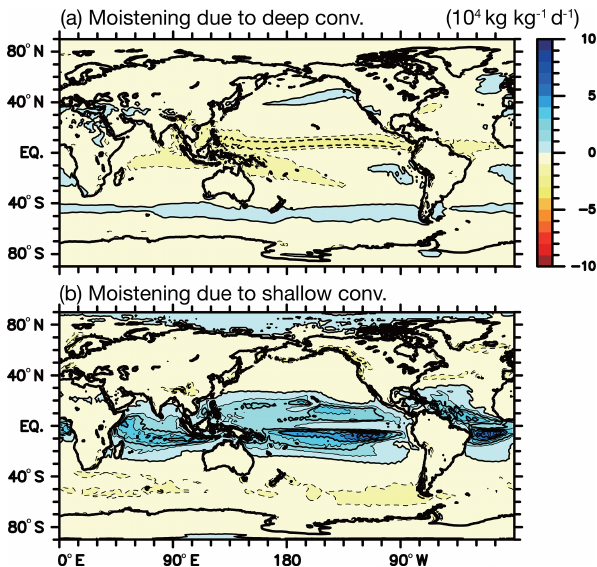
Figure 5. Annual mean moistening rate associated with (a) deep convection and (b) shallow convection in MIROC6 at the 850hPa pressure